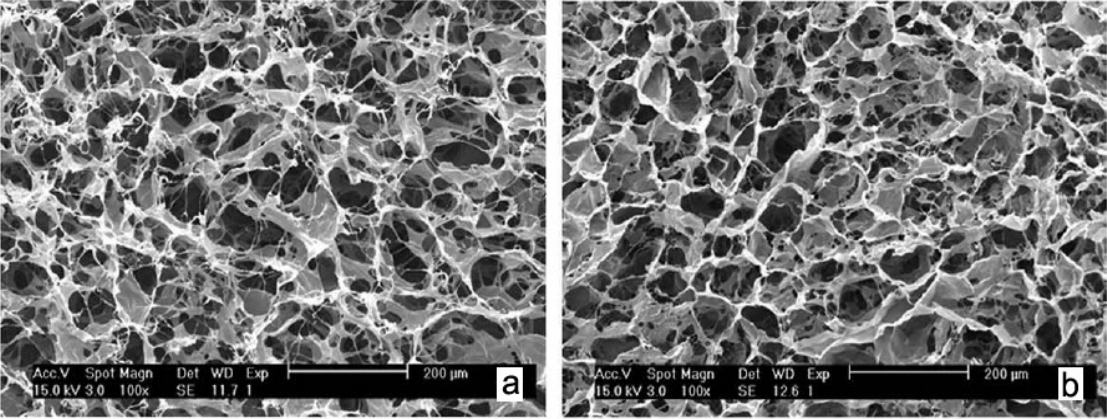
Figure 3. The SEM images of ( a ) uncross-linked and ( b ) 0.3% genipin cross-linked collagen/chitosan scaffolds with 90/10 in blend ratio, reprinted with permission from [106]. Copyright 2010 Wiley Periodicals,